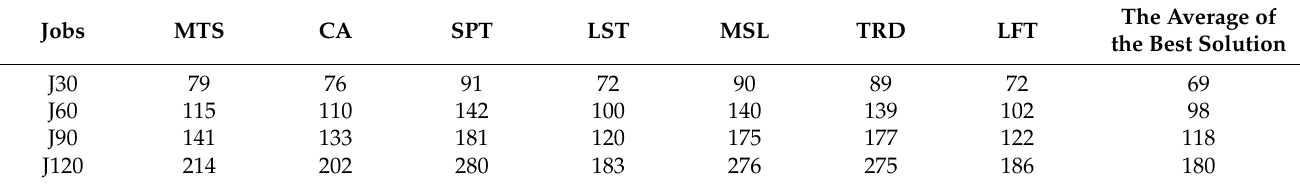
Table 6. Mean makespans of the serial schedule scheme-based methods.